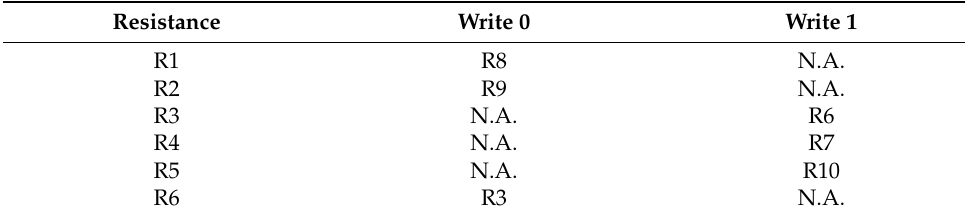
Table 1. Defect correspondences due to the symmetry of the